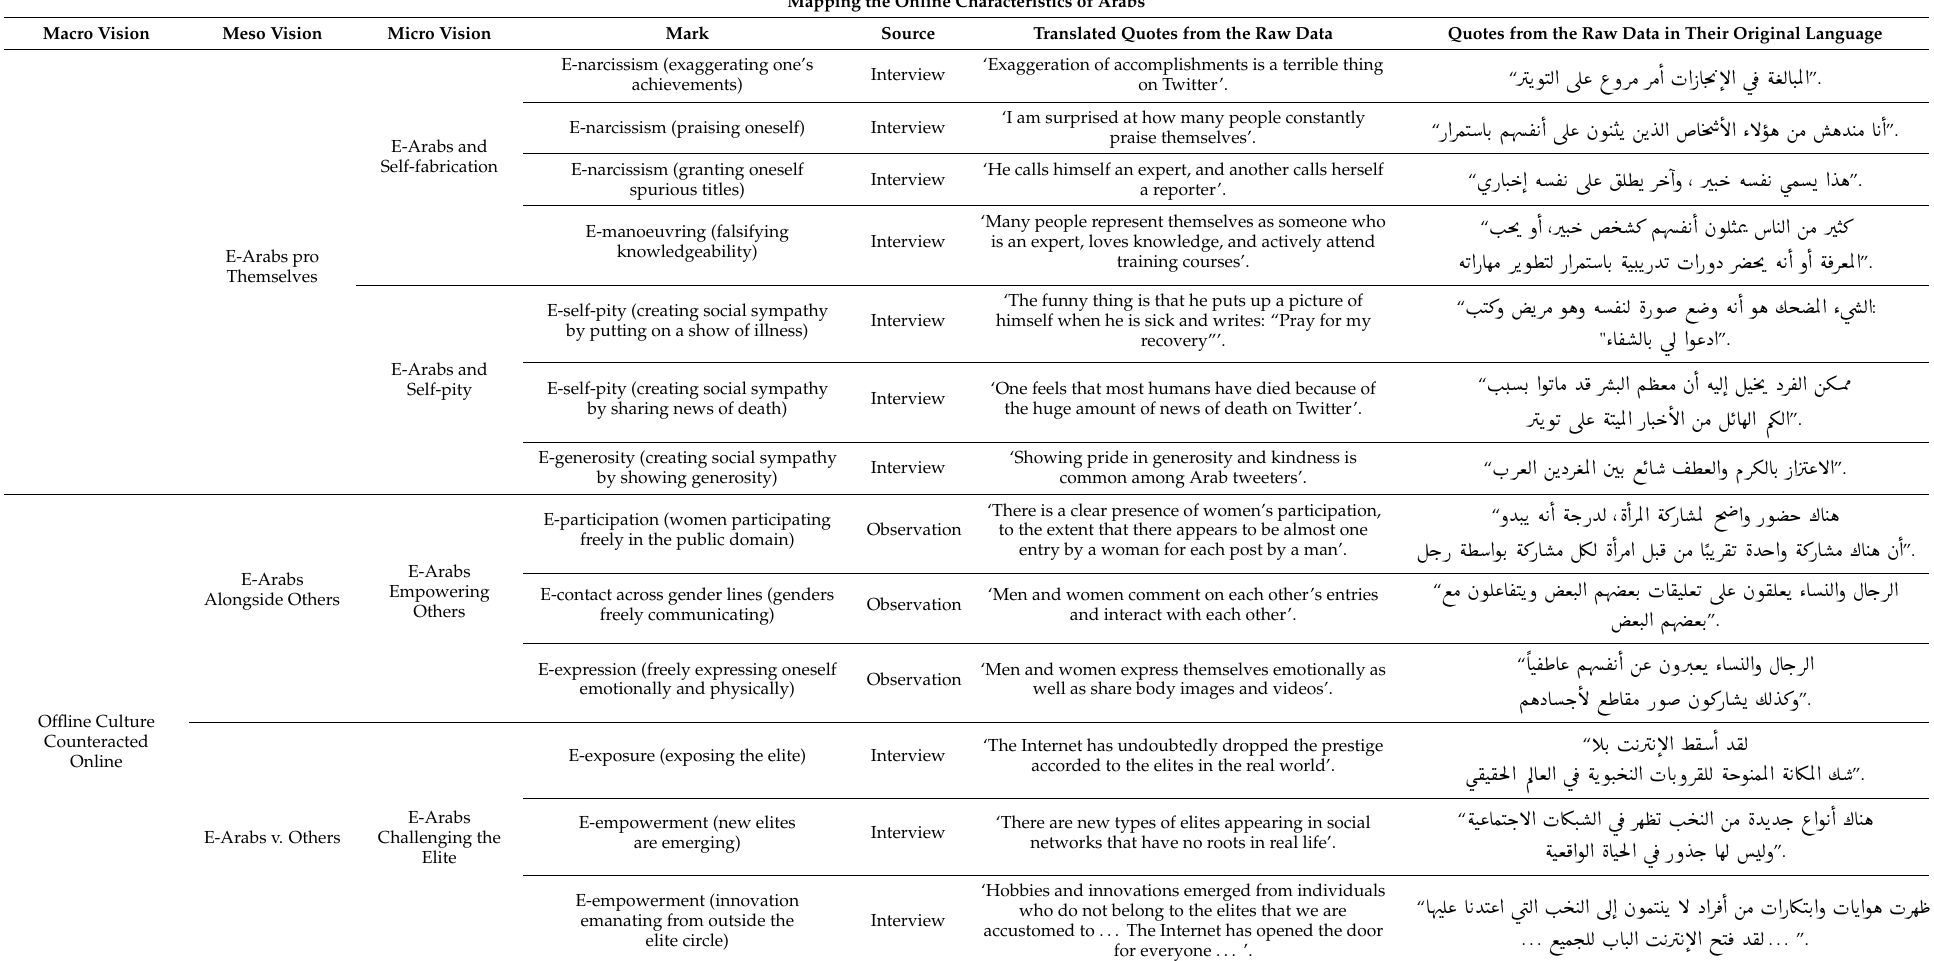
Mapping the Online Characteristics of